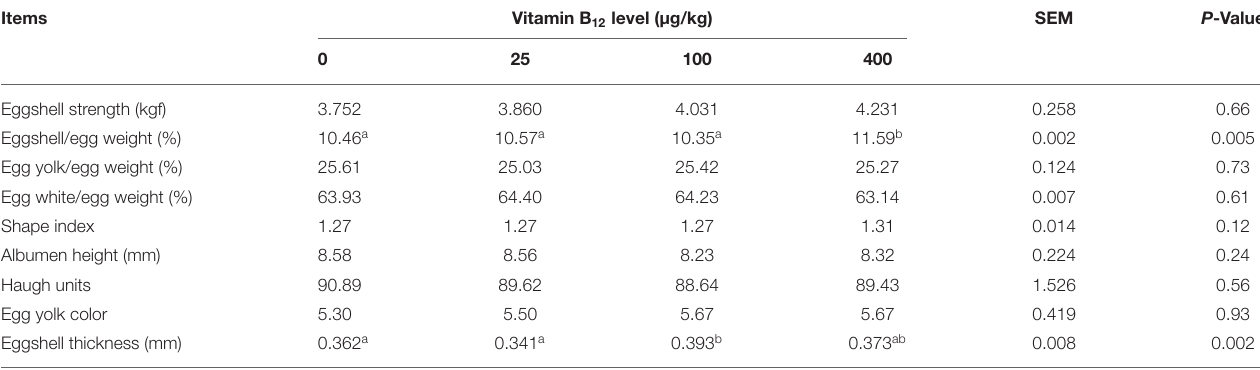
TABLE 4 | Effects of dietary supplementation of vitamin B 12 on the serum indicators of laying hens * . Items